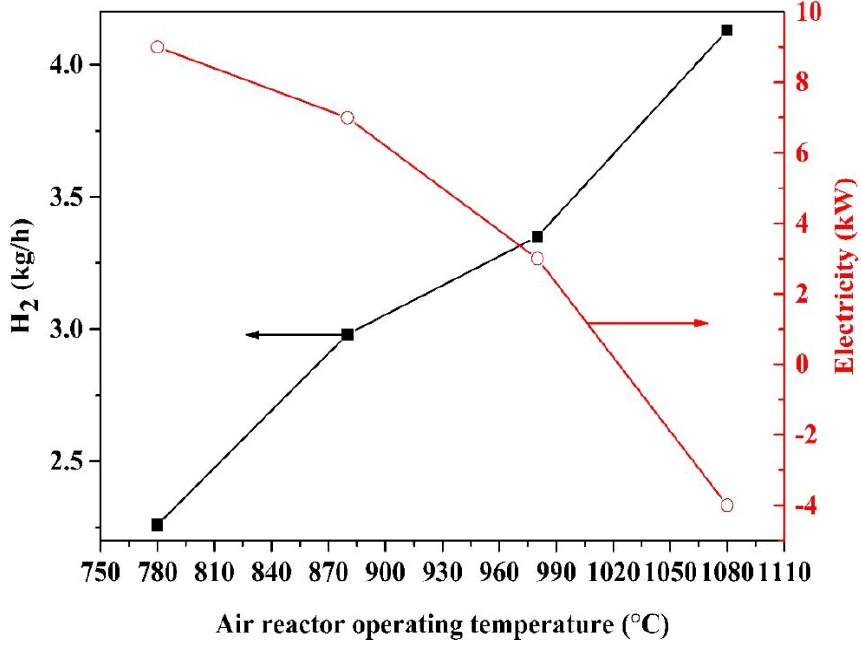
Figure 6. Influence of the air reactor operating temperature on hydrogen and electricity production, the temperatures of the pyrolysis reactor, fuel reactor and steam reactor are 500 ◦ C, 900 ◦ C and 700 ◦ C. The temperatures of the pyrolysis reactor, fuel reactor and steam reactor are kept at 500 ◦ C, 900 ◦ C and 700 ◦ C, respectively. As the air reactor operating temperature increases from 780 ◦ C to 1080 ◦ C, the hydrogen production yield enhances from 2.26 kg/h to 4.13